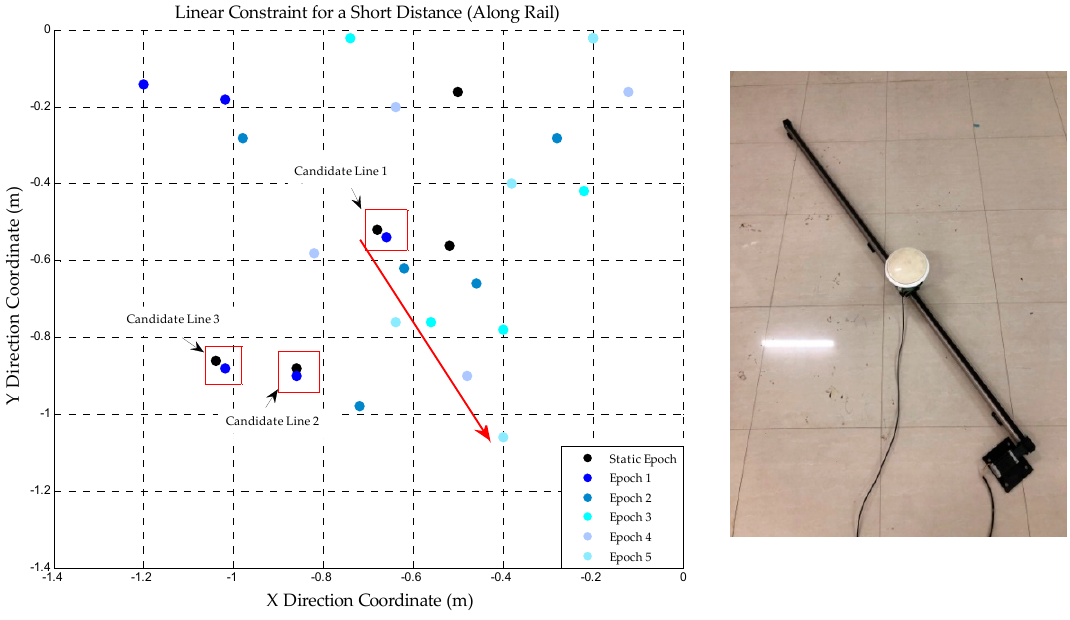
Figure 9. The trajectory obtained by AFM during the linear constraint (along rail), the right image shows the fixed rail for linear constraint test